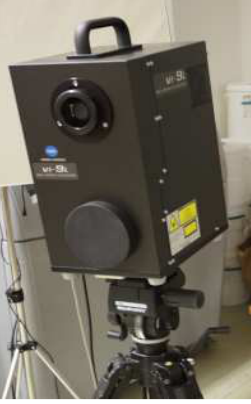
Figure 1. Triangulation scanner Konica-Minolta Vivid 9i In this case, the plaster cast was scanned from the several directions due to the incorporation of shielded parts of the object. The scanner was placed on a fixed tripod, while the object was rotated in order to attain the complete model.